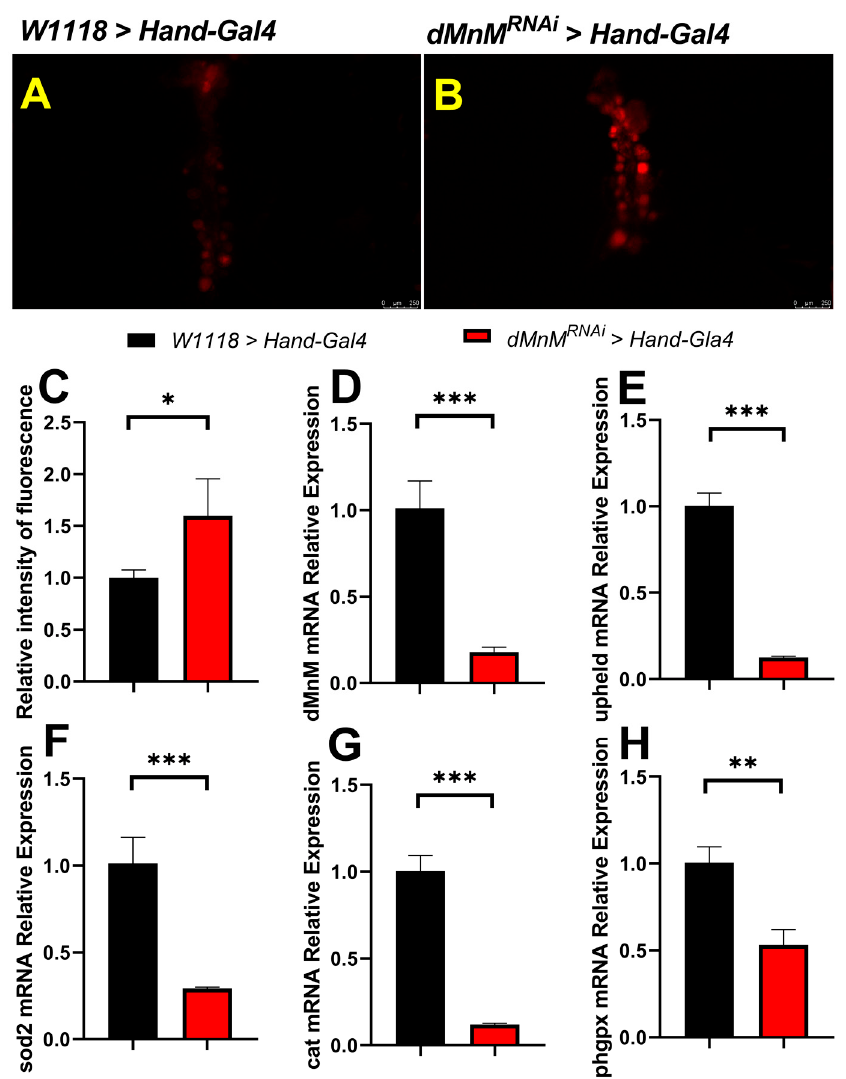
Figure 3. Effects of dMnM knockdown in cardiac myocytes on oxidative stress in the heart and mRNA expression of dMnM, upheld, sod2, cat, and phgpx. ( A , B ) Fluorescence images of cardiac DHE staining in the W1118 > Hand-Gal4 and dMnM RNAi > Hand-Gal4 groups, respectively, n = 5. ( C ) Relative fluorescence intensity of the heart. ( D – H ) Relative expression levels of dMnM, upheld, sod2, cat, and phgpx mRNA in Drosophila cardiomyocytes, respectively, n = 30. T-test for differences between the two groups using independent samples, * p < 0.05, ** p < 0.01, *** p < 0.001.